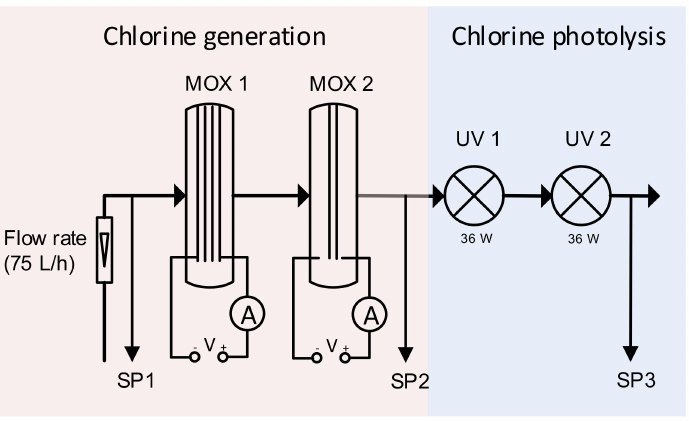
Figure 2. Lab test setting for performance evaluation of chlorine and radical